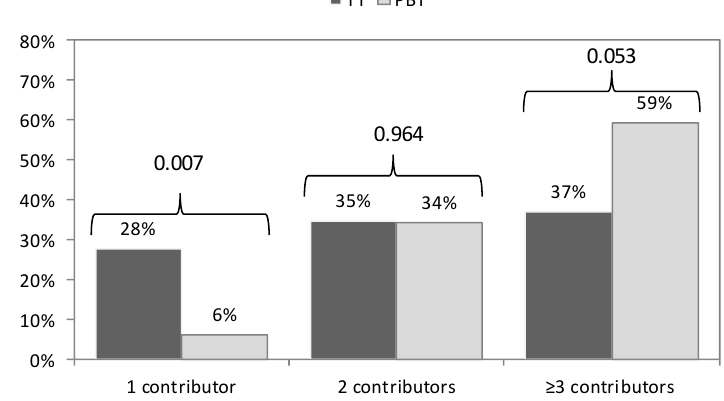
Figure 2. PhD theses distribution according to their format and the number of contributors involved (TT = Traditional theses; PBT = Publication-based theses).